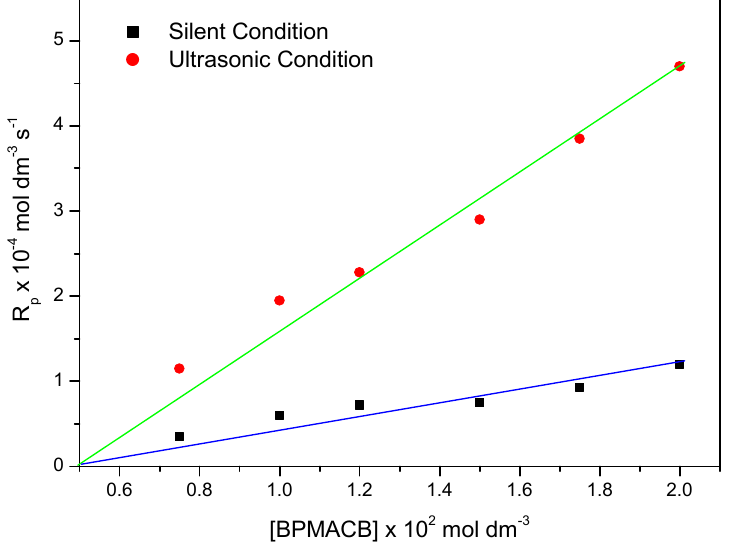
Figure 7. Plot of R vs. [BPMACB] under US-MPTC and Silent-MPTC conditions: p 2.00 × 10 − 2 mol·dm − 3 of PPS, 3.0 mol·dm − 3 of MABE, 0.3 mol·dm − 3 of [H + ],